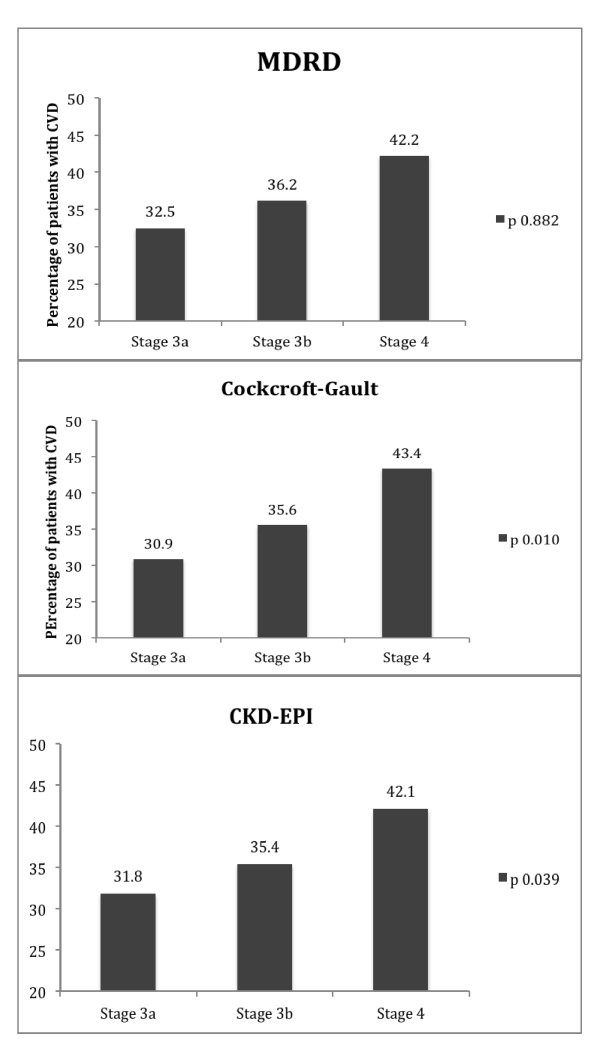
Overall cardiovascular disease (CVD). An increase in CVD is shown as GFR declines using MDRD formula, upper panel, Cockcroft-Gault formula middle panel, and EPI-CKD formula lower panel. The increase in CVD is statistically significant using the Cockcroft-Gault, and EPI-CKD formula but not with MDRD formula.